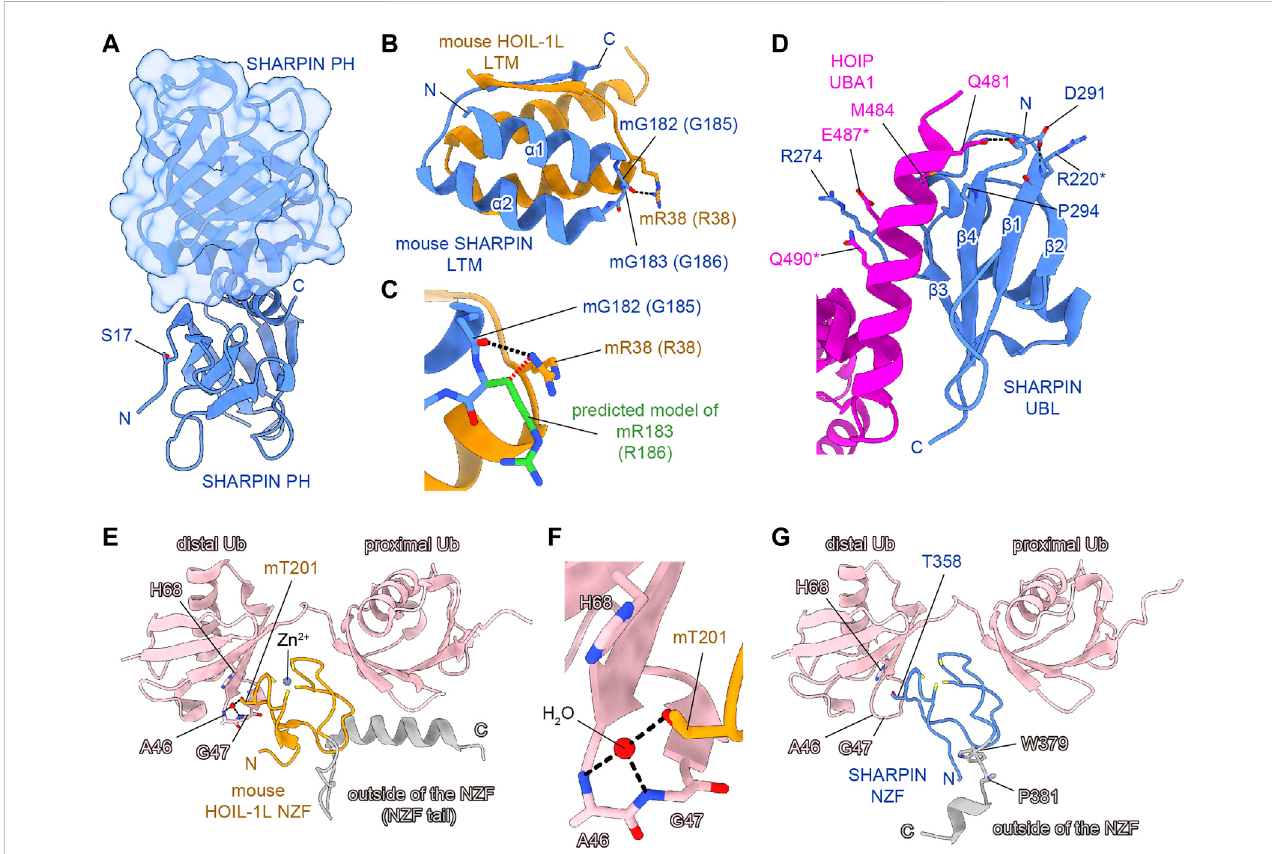
FIGURE 3 Structural simulations of AD-associated SHARPIN SNP sites. SHARPIN, HOIL-1L, HOIP, and M1-linked diubiquitin are colored blue, orange, purple, and pink, respectively. Hydrogen bonds areshown as blackdashed lines. (A) Crystal structure ofthehuman SHARPIN PH homodimer (PDB 4EMO).Oneprotomer isshownasacartoonmodel,andtheotherisshownasatranslucentsurfaceandcartoonmodel. (B) Close-upviewoftheinterfacebetweentheSHARPINLTM and HOIP LTM in the crystal structure of the hetero-trimeric core of mouse LUBAC (PDB 5Y3T). Numbers in parentheses indicate the corresponding human protein residues. (C) Structural simulation of the G183R mutation of mouse SHARPIN (equivalent to G186R mutation of human SHARPIN). The predicted model of mR183 is colored green. Rotamers of mR183 are selected to be in the opposite orientation to the mR38 of mouse HOIL-1L. The steric hindrancebetweentheC β ofSHARPINmR183andHOIL-1LmR38isindicatedbythereddashedline. (D) Close-upviewoftheinterfacebetweentheSHARPIN UBLandtheHOIPUBA1inthecrystalstructureofthehumanSHARPINUBLandHOIPUBA1-UBA2complex(PDB5X0W).Asterisksindicateresidueswithweak electron density and no side chains, according to the PDB model fi le. (E) Crystal structure of the mouse HOIL-1L NZF and M1-Ub 2 complex (PDB 3B08). (F) Close-up view around the mT201 of mouse HOIL-1L NZF in (E) . (G) Structure of the human SHARPIN NZF and M1-Ub 2 complex predicted by AlphaFold2. Since AlphaFold2 currently cannot predict a non-protein structure, the zinc ion and water molecules are not shown. Regions outside of the NZF are colored gray in (E,G)